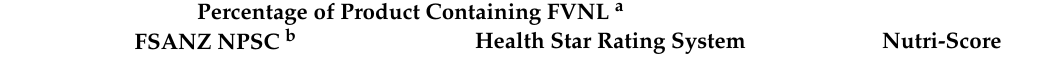
Table 1. The point systems for estimating the proportion of a packaged food or beverage product containing fruits, vegetables, nuts, legumes or rapeseed, walnut and olive oils (FVNL) a